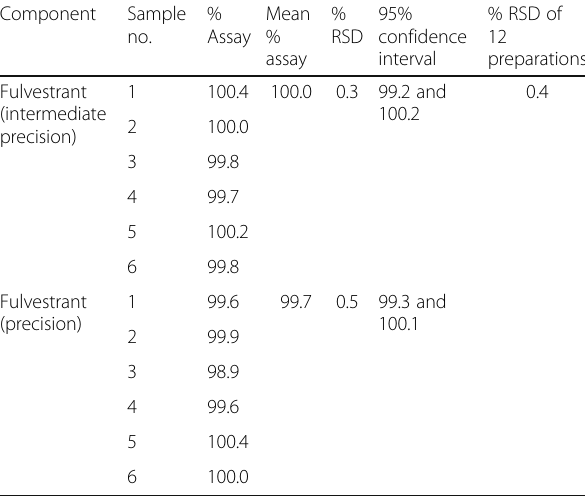
Table 4 Precision and intermediate precision results